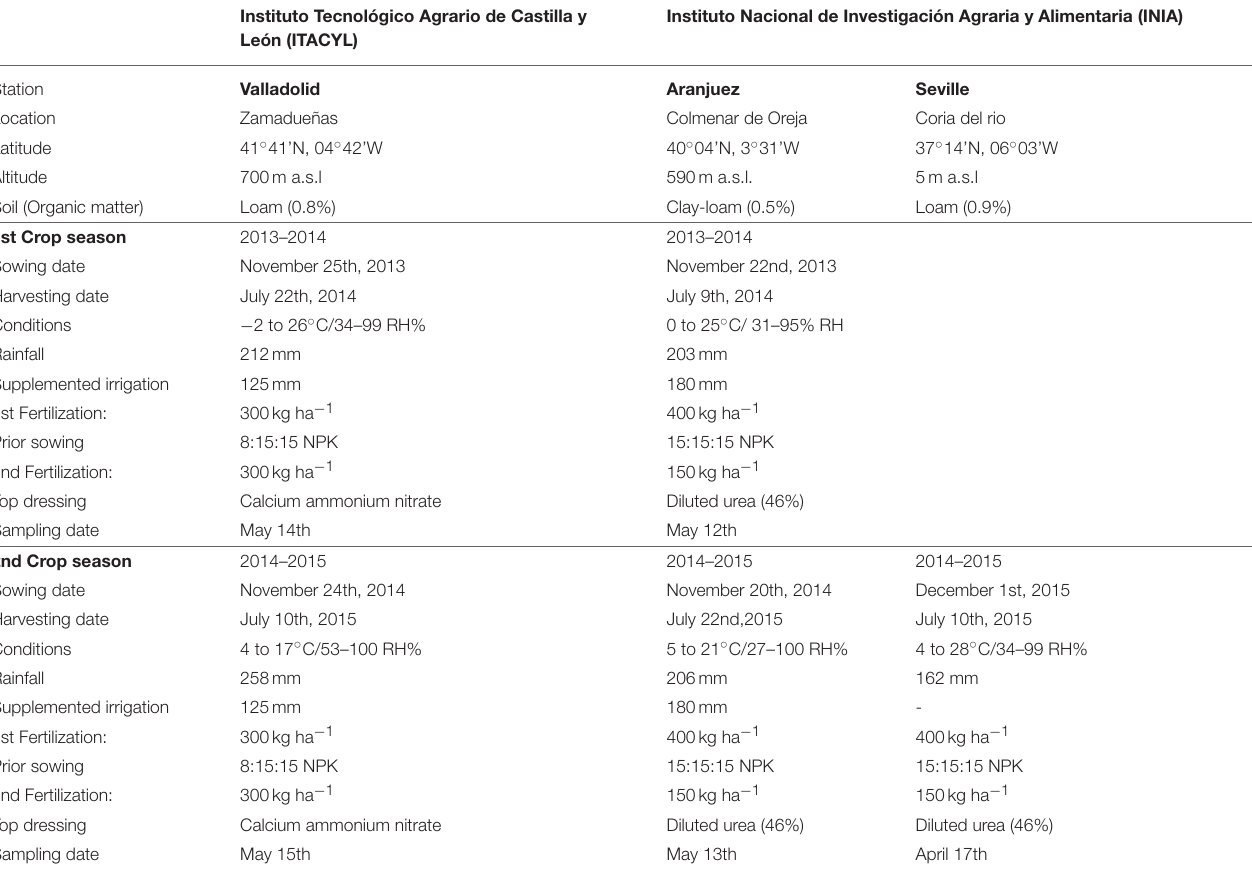
TABLE 2 | Field experimental trial